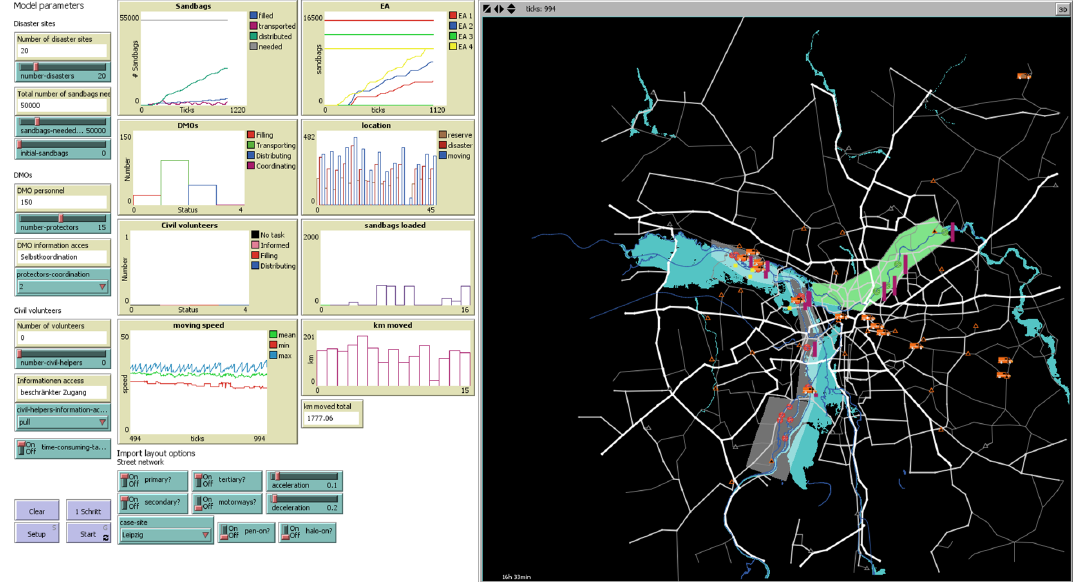
Figure 3. Screenshot of the NetLogo model interface. The map shows a snapshot of a running simulation, with DMO agents moving along the street network and disaster sites in various states of protection. The green shaded area depicts a river section that is already protected whereas in the grey shaded areas sandbags are still needed at various